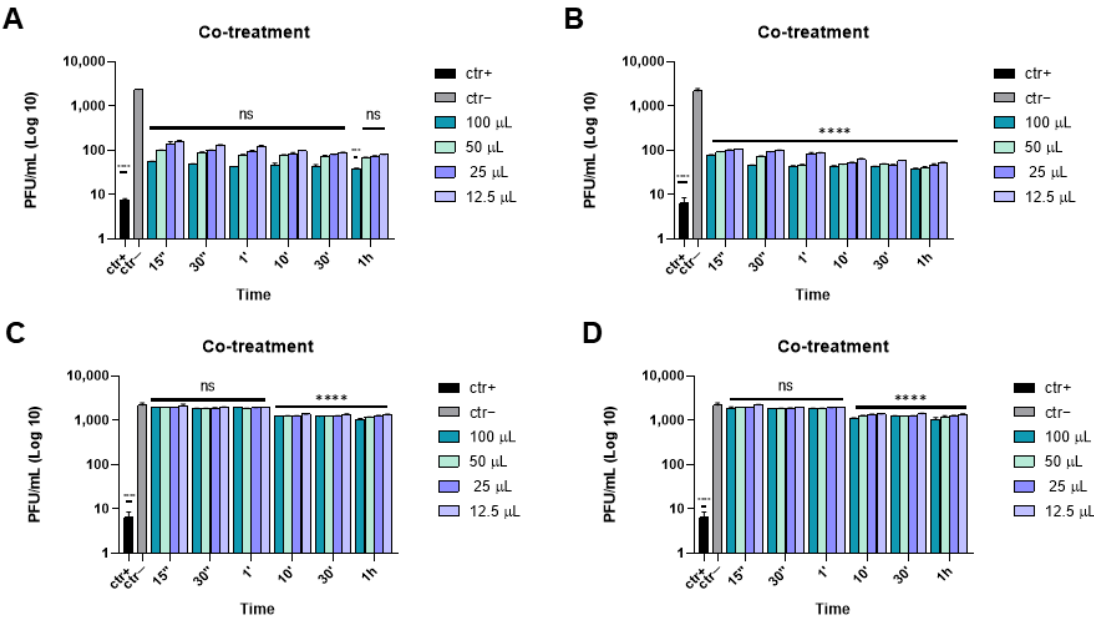
Figure 1. Co-treatment assay of the antiviral activity of ophthalmic solutions against HSV-1 at different times of incubation. Iodim ( A ), Ozodrop ( B ), Dropsept ( C ), and Septavis ( D ) were incubated simultaneously with HSV-1 on Vero cells. Melittin [35] was used as a positive control (ctr+). Data are means of three independent experiments. Statistical analyses were determined by two-way ANOVA, followed by a Bonferroni post hoc test. Significance refers to the negative control (ctr–), i.e., the infected cells. **** p < 0.0001; ns: non-significant. Table 2. CC50, IC50 and TI corresponding to each incubation time calculated for Iodim and Ozodrop.